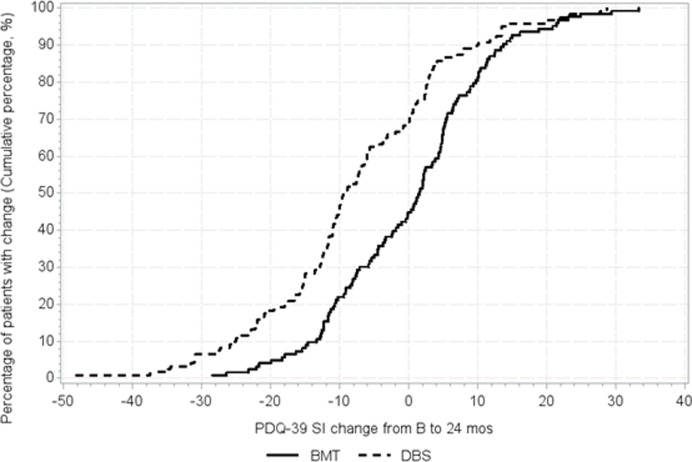
Cumulative distribution curves of PDQ-39 change from baseline to 24 months (1-cumulative %).